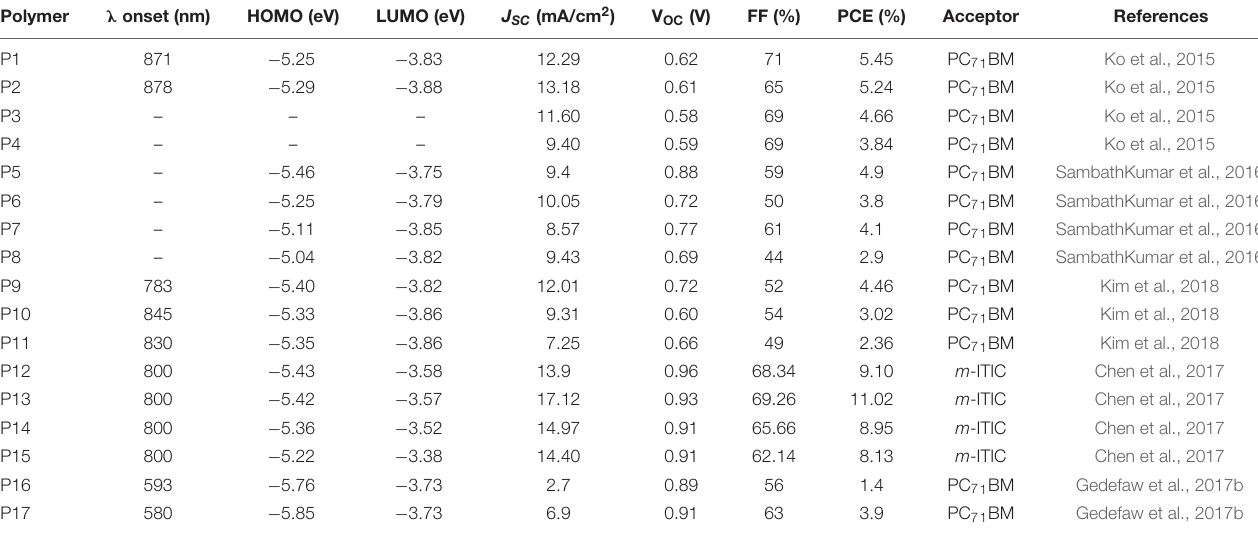
TABLE 1 | Summary of optical, electrochemical, and photovoltaic properties of polymers ( P1 – P17 ). Polymer λ onset